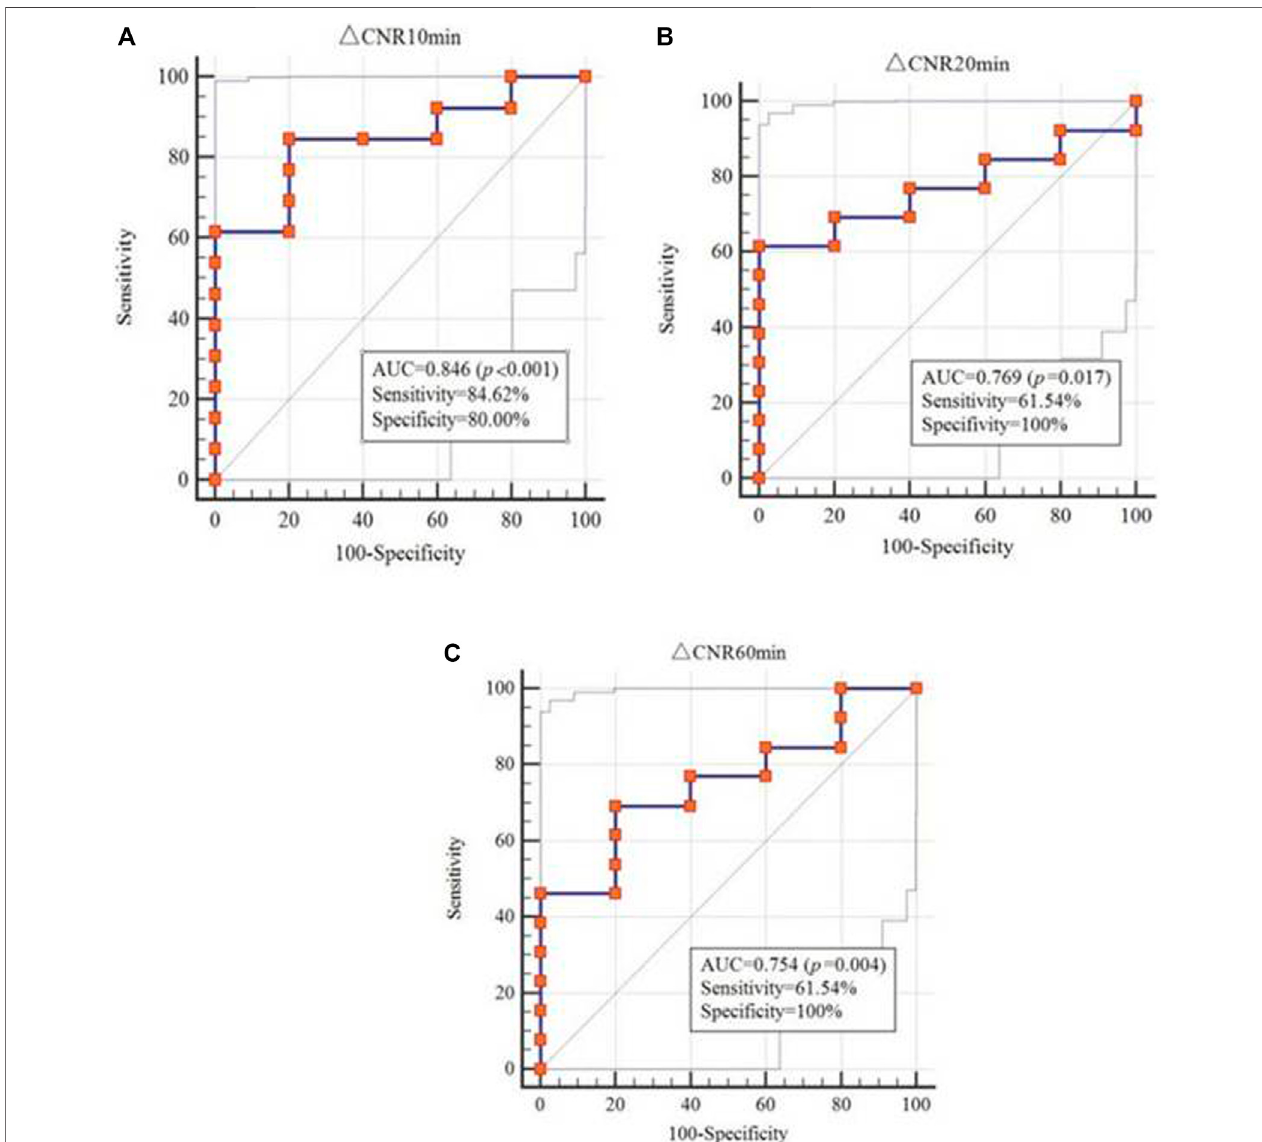
FIGURE 6 | ROC analysis of Δ CNR to differentiate between none-to-mild and moderate-to-severe fi brosis.